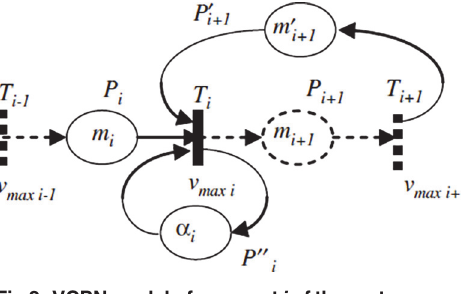
Fig 2. VCPN model of segment i of the